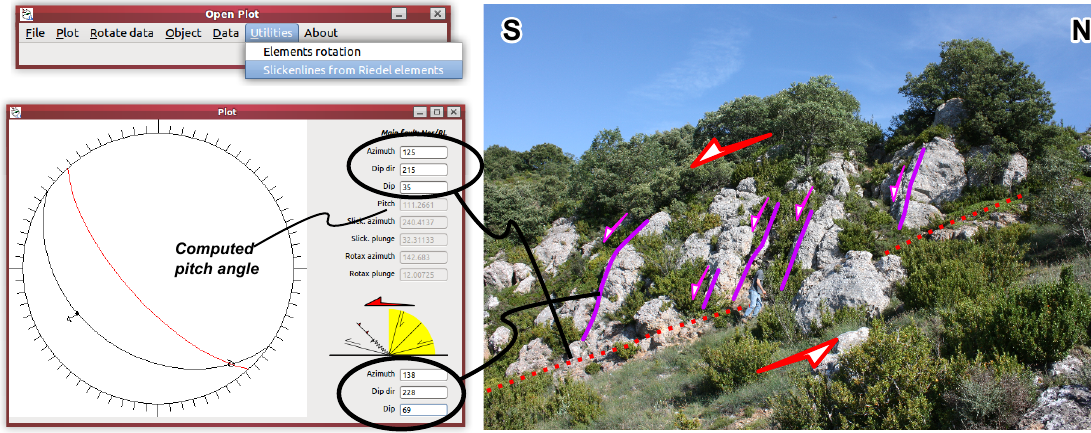
Fig. 5. How to use the Slickenlines from Riedel elements utility to get the fault pitch angle.